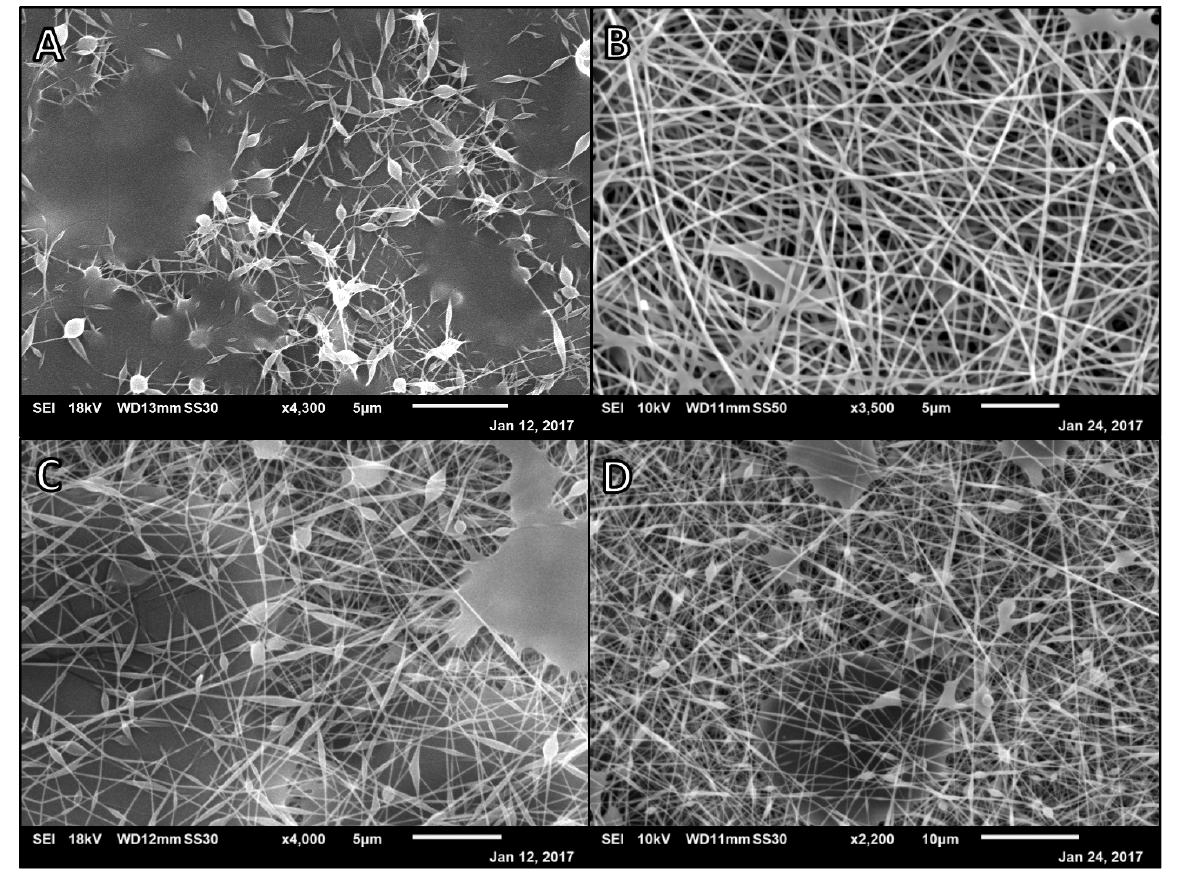
Figure 2. SEM micrographs of 2.5% Alg:10% PVA nanofibers at 7.5 μL/min, 100 mm, and different ratios. ( A ) 8:2 2.5% Alg:10%PVA at 20 kV and 0.99 mL disp.; ( B ) 7:3 2.5% Alg:10% PVA at 25 kV and 2 mL disp.; ( C ) 1:1 2.5% Alg:10% PVA at 30 kV and 2.5 mL disp.; ( D ) 2:8 2.5% Alg:10% PVA at 25 kV and 2 mL disp.